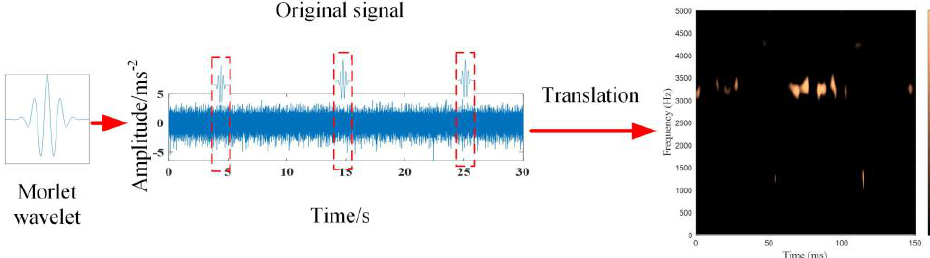
Figure 2. Two − dimensional time − frequency image generated by continuous wavelet transform.